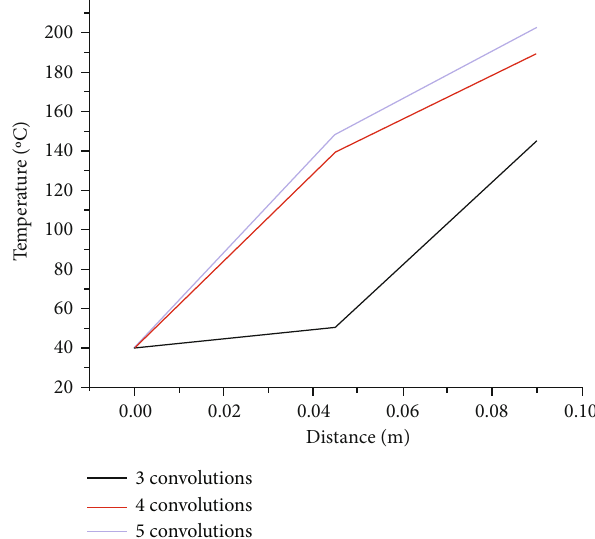
Figure 7: Temperature values at di ff erent positions of coil with varying number of